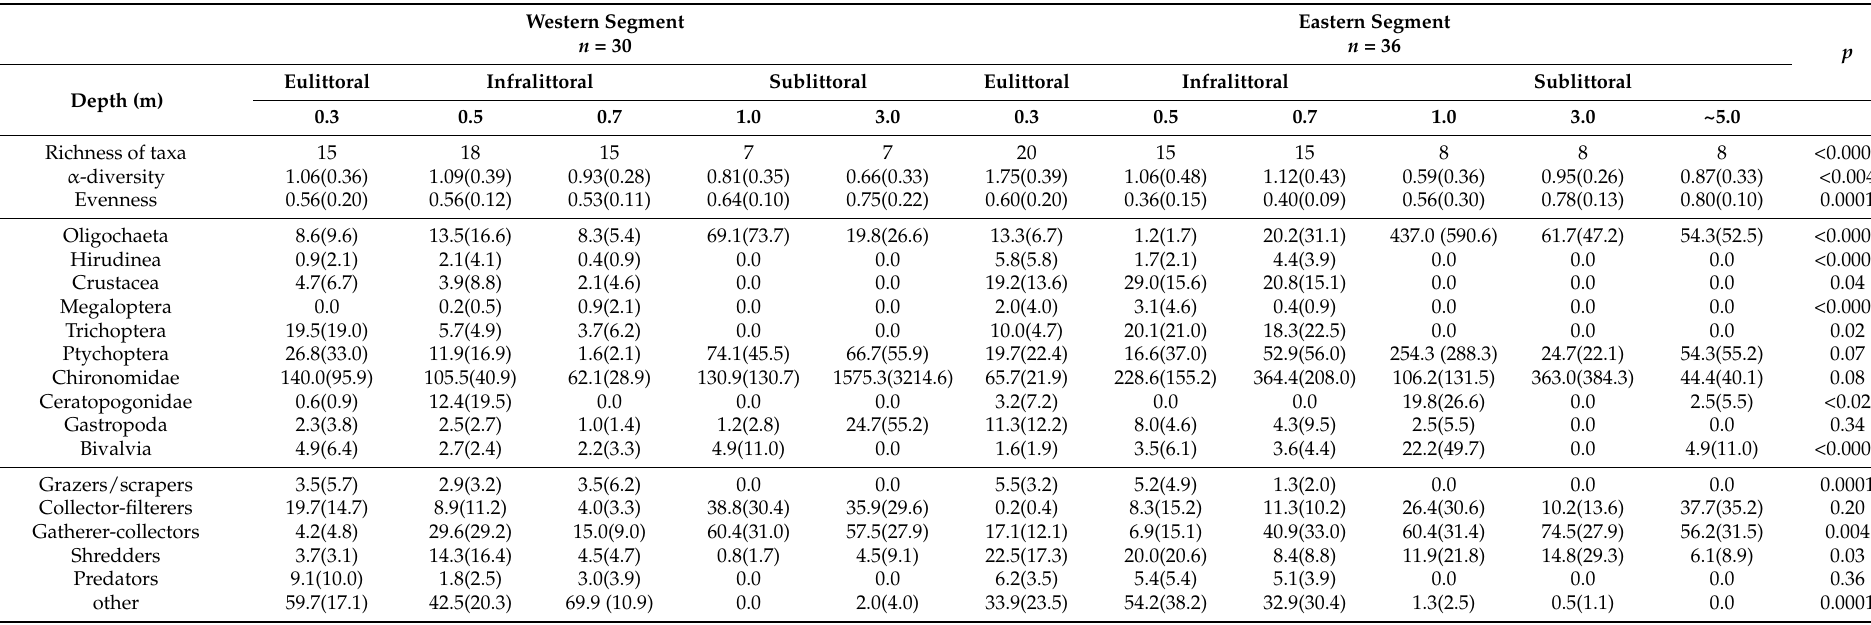
Table 2. Annual mean values of diversity indices and abundance (ind. m − 2 ± Standard Deviation) and FFG (%) of the invertebrate community in different depth zones of two segments of Lake Wicko in 2014–2015; p = significance of differences between zones (one-way ANOVA, p <